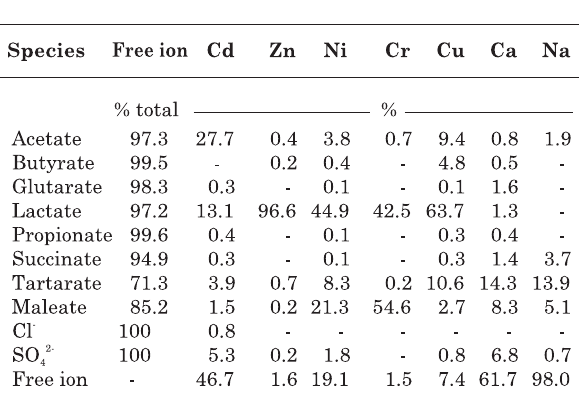
Table 4. Chemical species of metals successively extracted by the synthetic root exudates of 0.1 mol L -1 organic acid strength in back